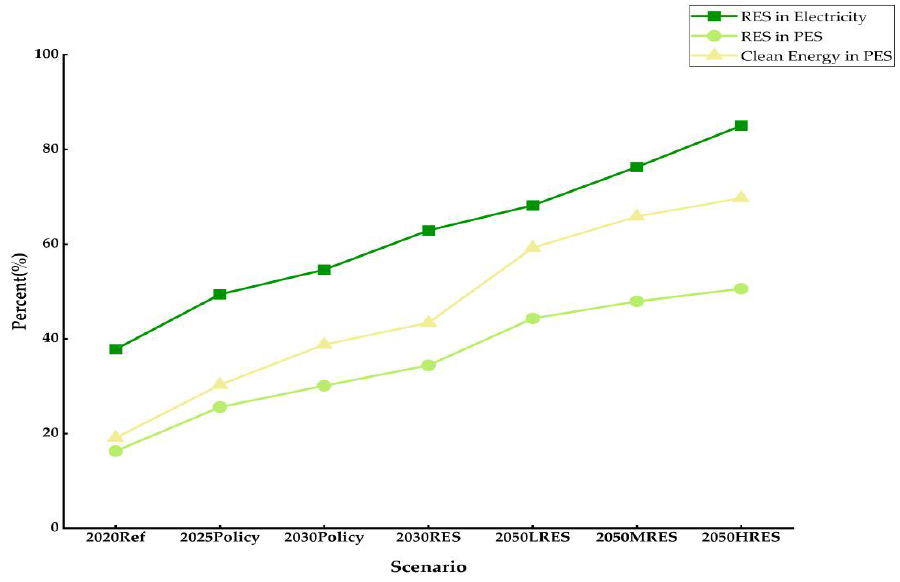
Figure 8. RES and clean energy share in the seven scenarios.